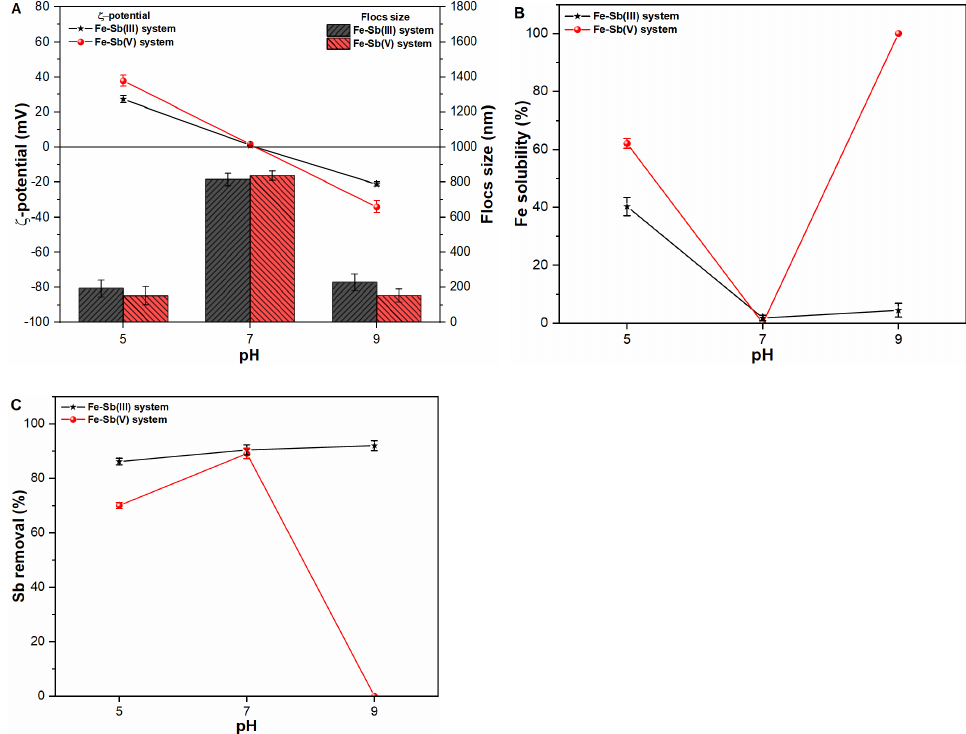
Figure 1. Influence of pH on ( A ) zeta potential (mV) and size (nm) of freshly formed Fe flocs; ( B ) Fe solubility (%) and; ( C ) Sb removal (%) in Sb(III, V) suspensions. .